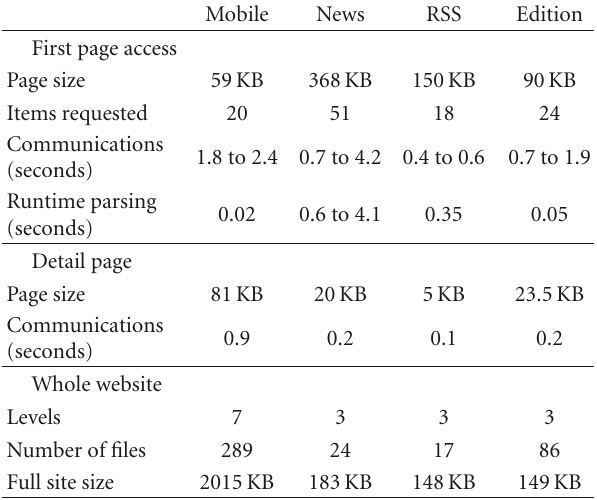
Table 3: Performance evolution of the of Web applications taking in account size and speed of the transferred content between server and